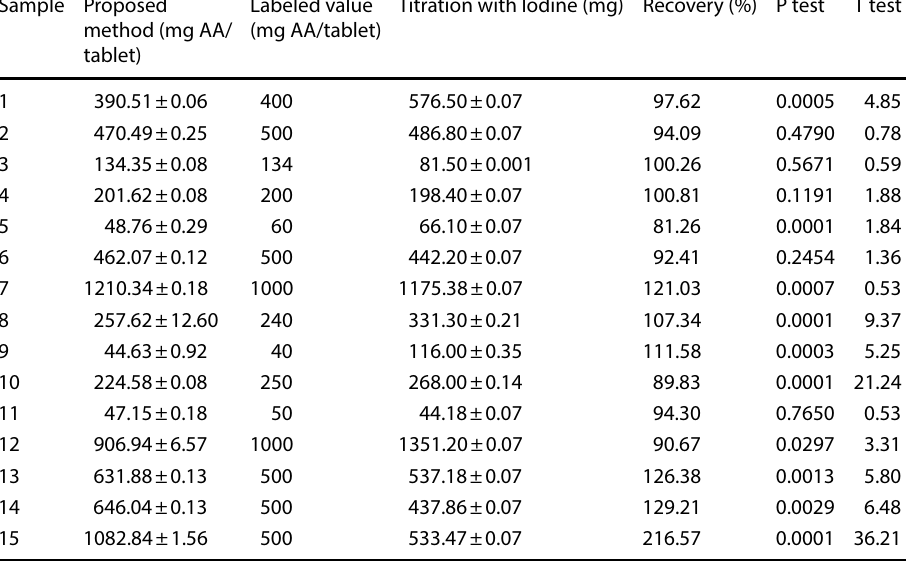
Table 5 Results of analysis of pharmaceutical samples determined by the developed method and by the iodine